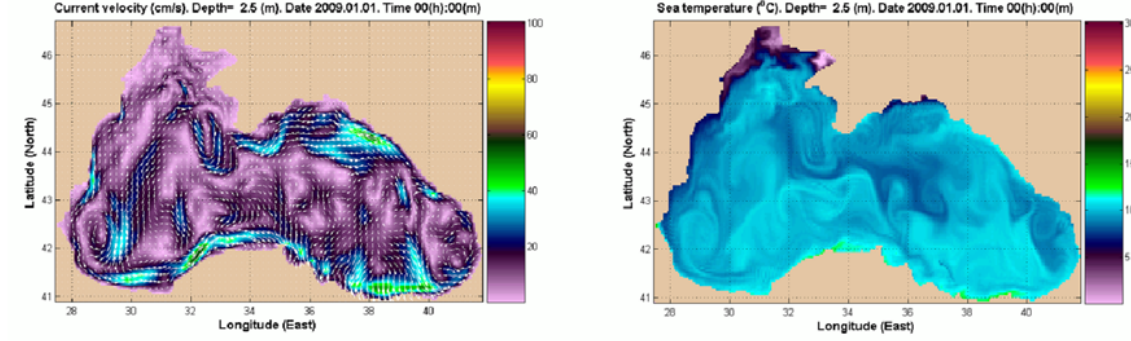
Examples of the system products presented on the web are shown on Figure 26.